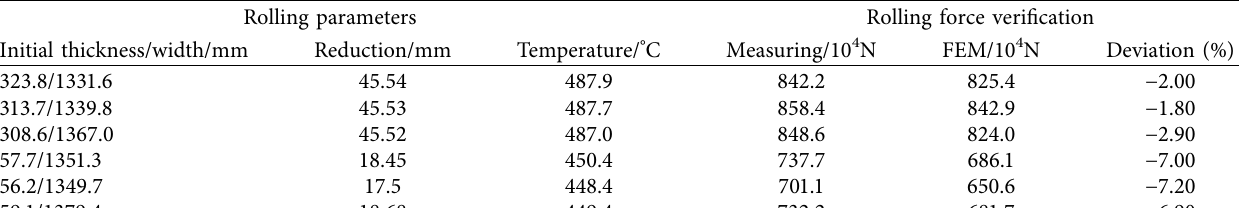
Table 2: Rolling conditions and the rolling force.